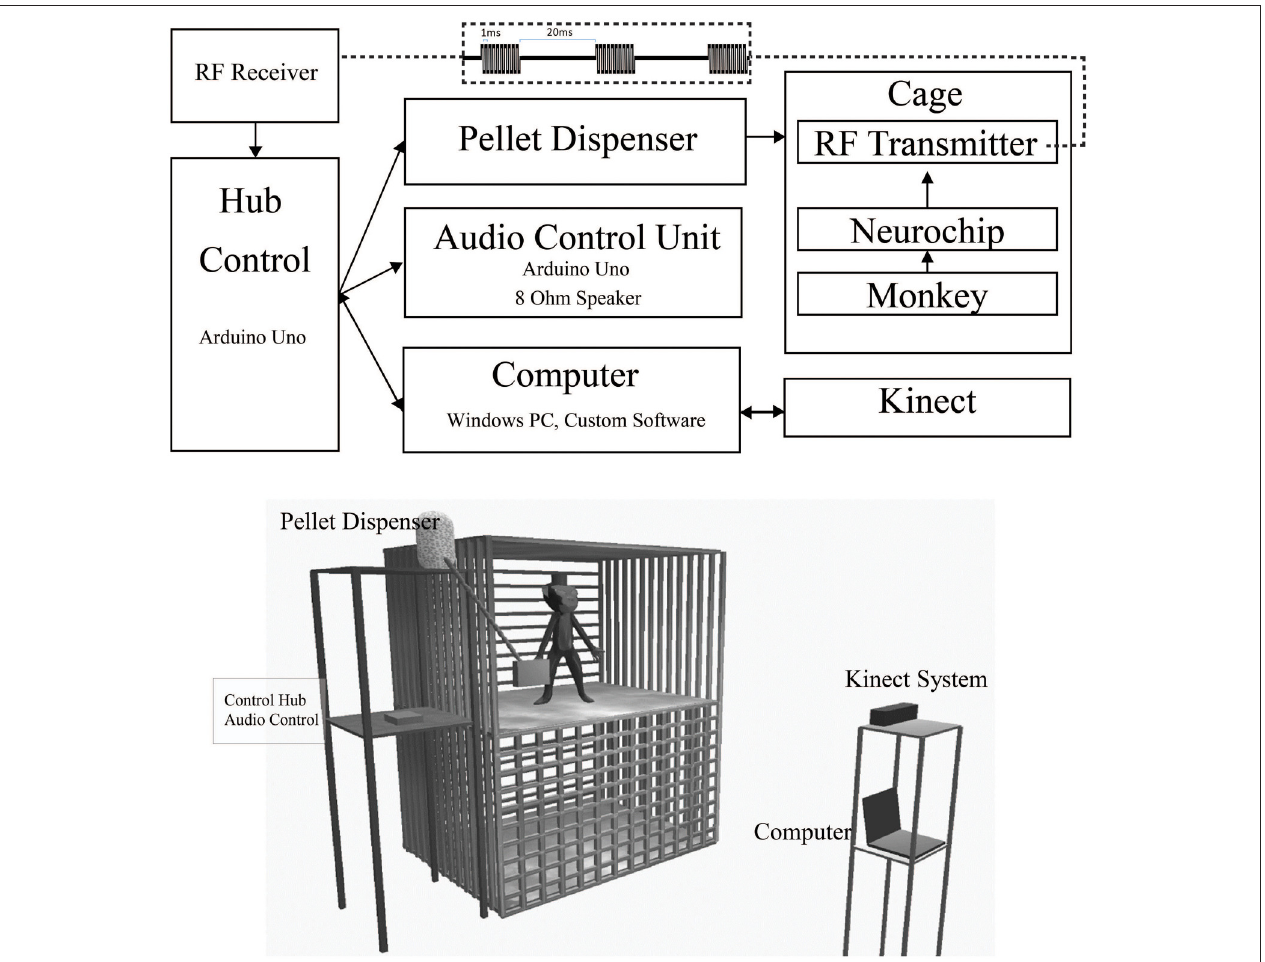
FIGURE 1 | Free-behavior hardware setup. The overall system consists of off-the-shelf components and custom programmed control units. Top. Block Diagram of primary hardware components. Wired/wireless connections are indicated by solid/dashed lines. Bidirectional USB communication is indicated by double ended arrows. Wireless RF waveform is indicated by the top dashed inset. Bottom . In-cage system setup. The 3’ × 3’ × 3’ cage is made of metal. The front bars in the top portion of the diagram have been removed to provide a clearer view of the monkey’s environment. The control hub, audio, and pellet dispensing units were mounted on a stand next to the monkey’s cage. The Kinect and computer were mounted on a separate stand outside the monkey’s